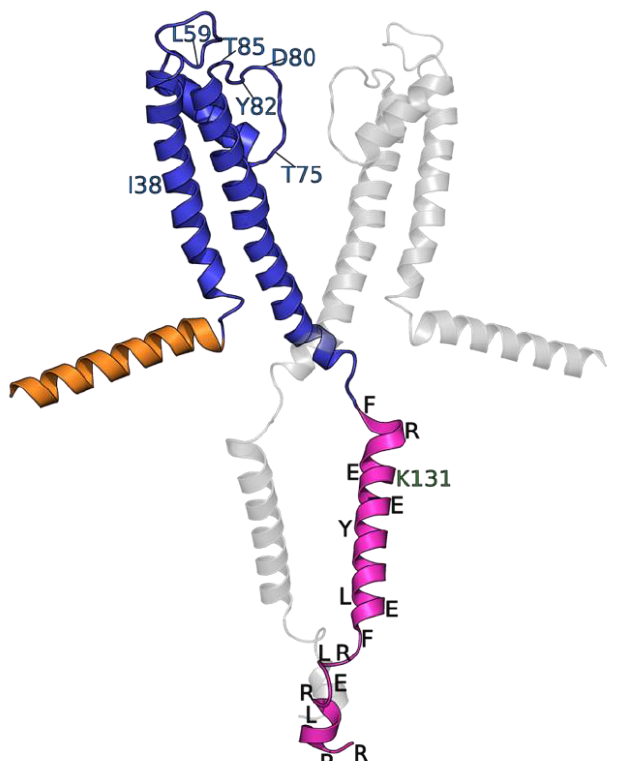
Figure 3. Cartoon of KcsA adapted from PDB: 1F6G [29], with two subunits hidden for clarity. Cytosolic N-terminus shown in orange (residues 1–22), transmembrane domain in blue (23–124), and cytosolic C-terminus in magenta (125–160). Resonances missing from CP-MAS 13 C- 13 C spectrum of KcsA– ∆ 125 are indicated with blue labels. Newly assigned Lys-131 indicated. Approximate locations of candidates for type-assigned resonances labeled in black with single letter amino acid code. Visualized with Pymol